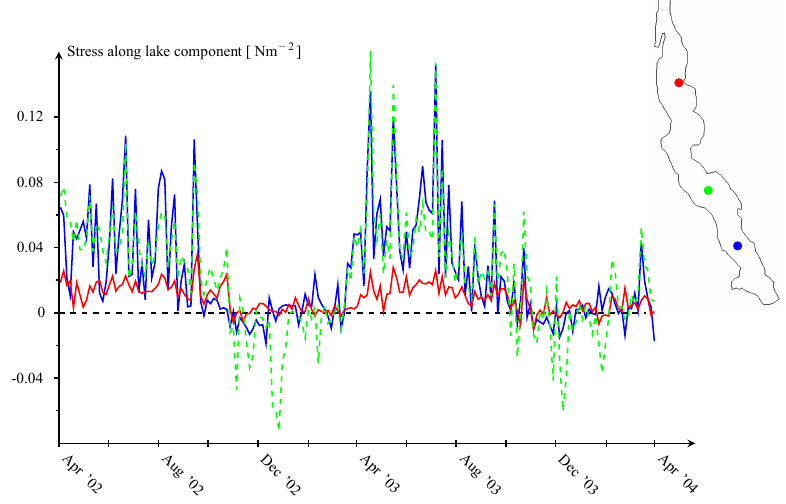
Figure 7. Along-lake component of the daily-averaged wind stress, at the northern, central and southern parts of the lake, between April 2002 and 2004, as modelled by the regional climate model COSMO-CLM 2 (Thiery et al., 2015).